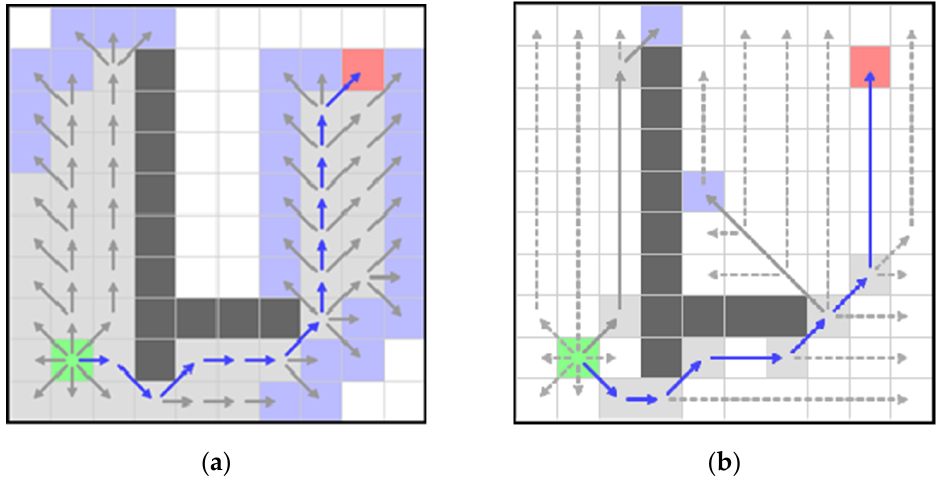
Figure 4. Comparison between A* algorithm and JPS algorithm for accessing nodes in the search process. ( a ) A* algorithm path ‐ planning process. ( b ) JPS algorithm path ‐ planning process.